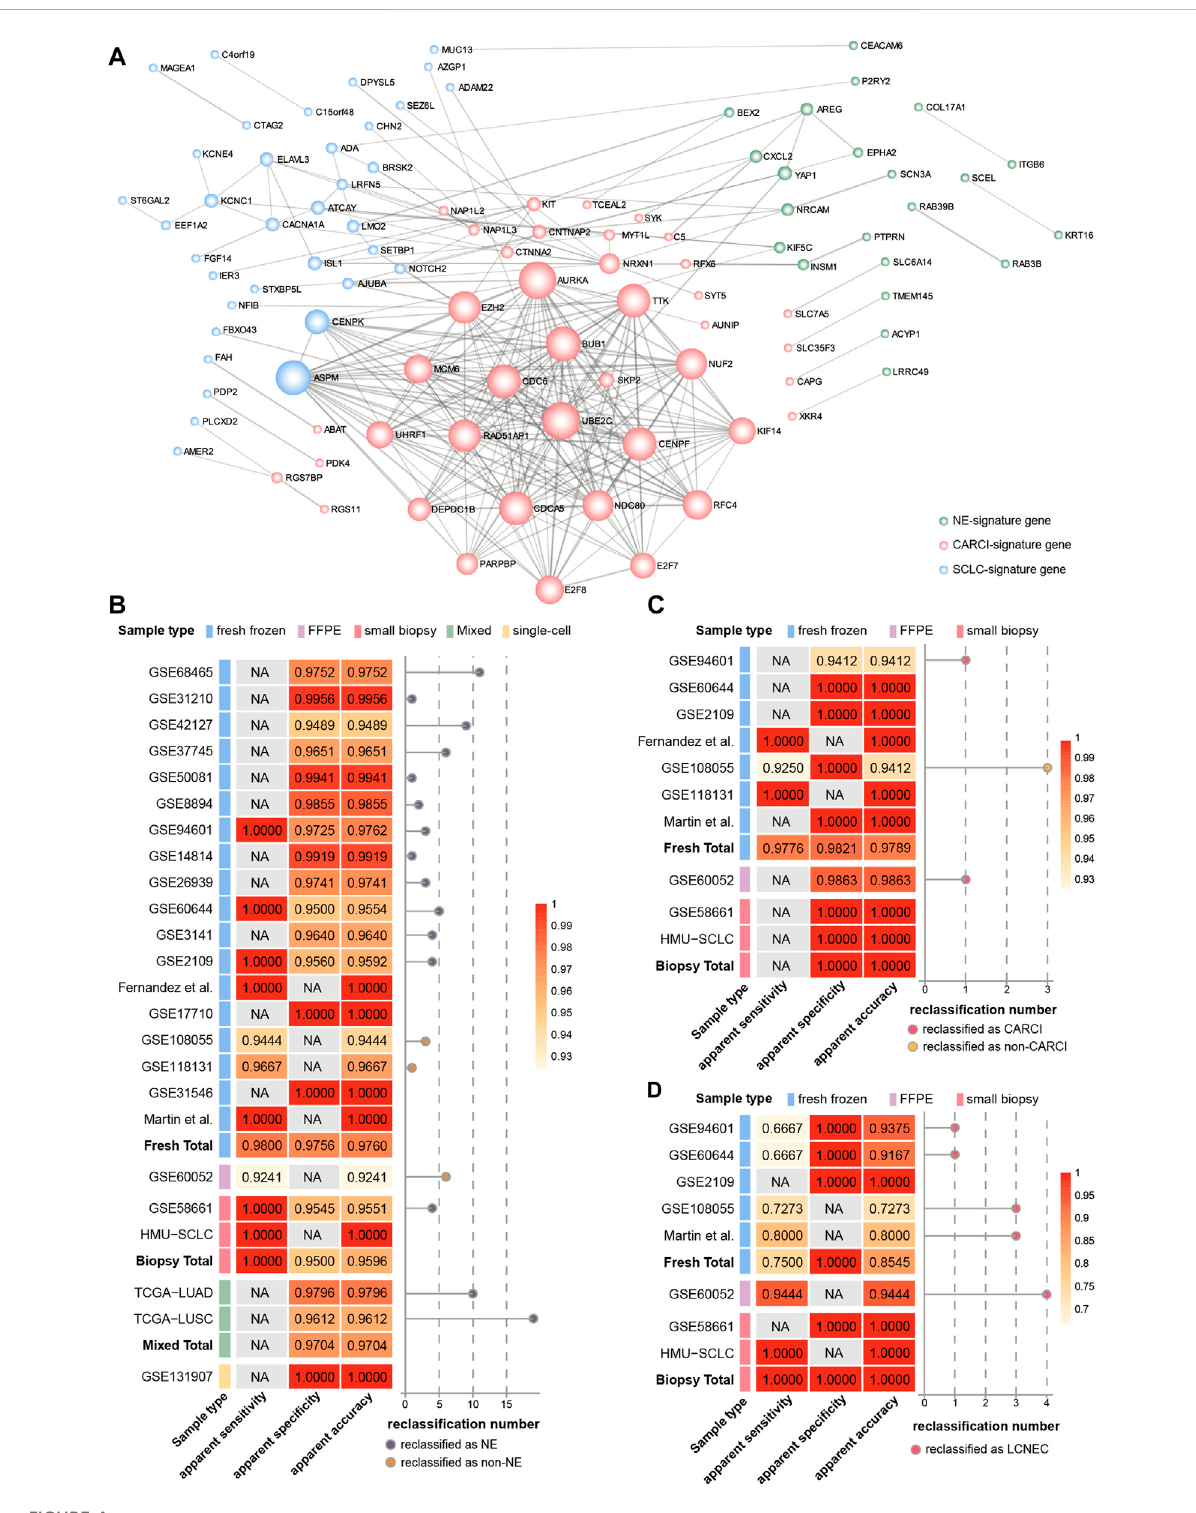
FIGURE 4 Hierarchical validation of the NEsubtype-panel. (A) protein – protein interaction network of genes in the NEsubtype-panel constructed using Cytoscape. The NE-signature, CARCI-signature, and SCLC-signature genes are marked in light green, pink, and blue, respectively. Line thickness indicates the strength of data support (interaction score by STRING). The apparent sensitivity, apparent speci fi city, and apparent accuracy of the (B) NE-signature, (C) CARCI-signature, and (D) SCLC-signature in multiple datasets. The left panel of each signature represents the classi fi cation accuracy of different sample types, and the right panel displays the number of reclassi fi ed samples. NE, neuroendocrine; CARCI, carcinoids; and SCLC, small-cell lung